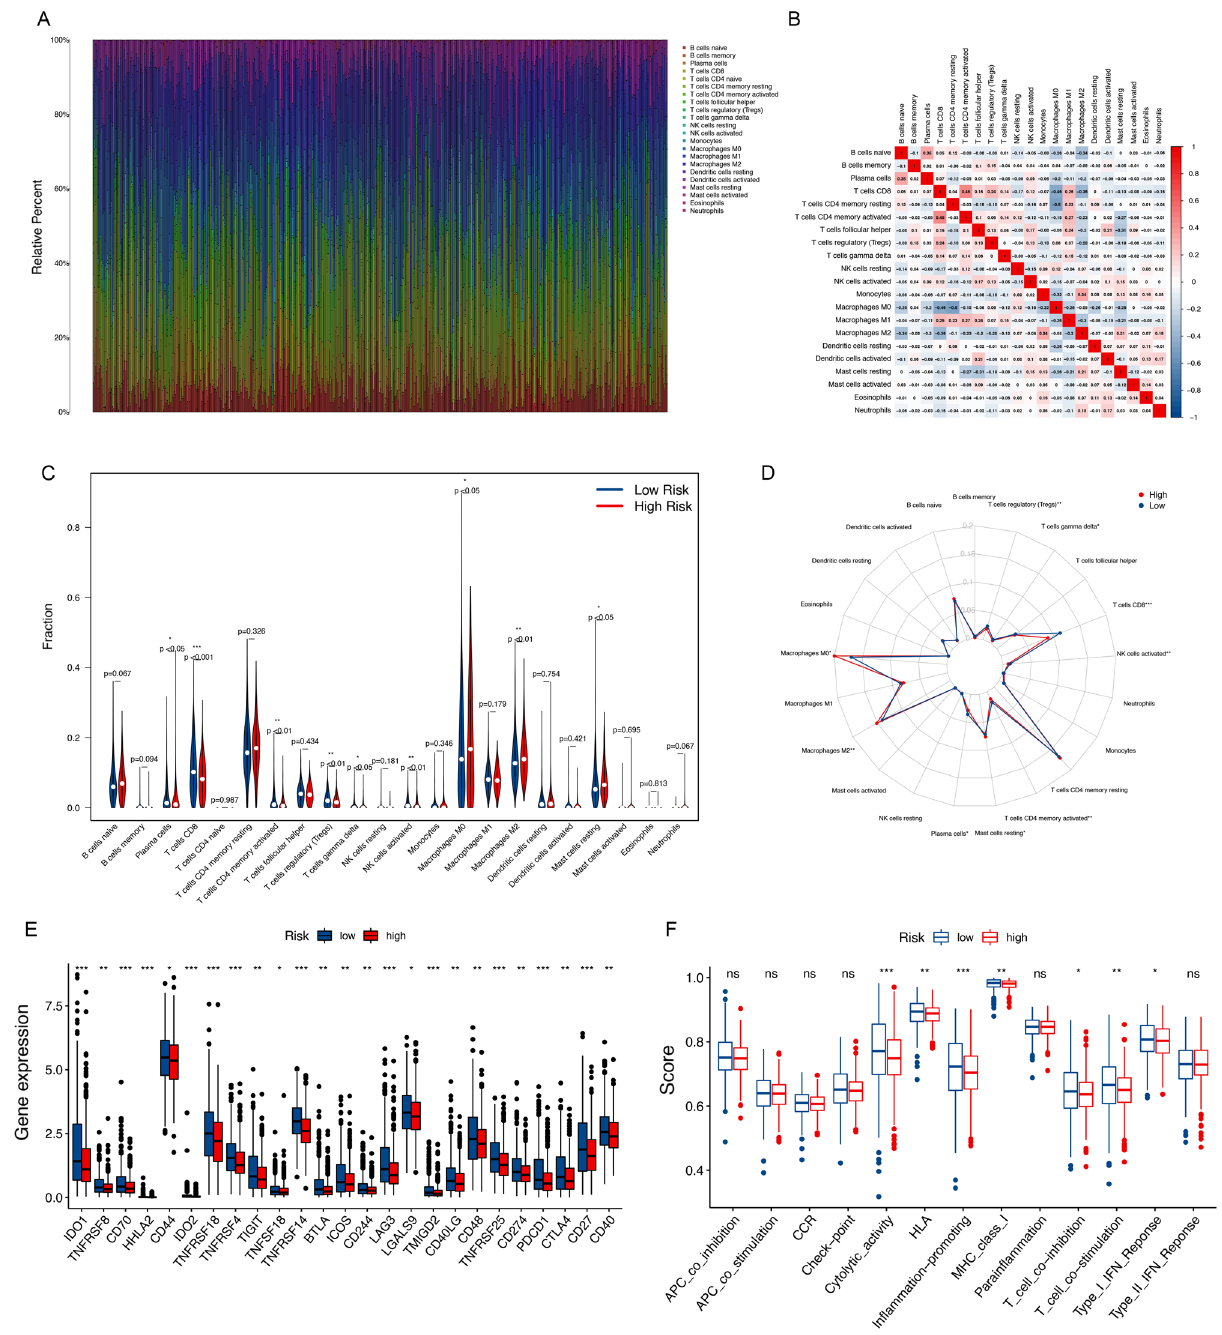
Figure 8. The immune cell infiltration landscape in BRCA. ( A ) Barplot of the proportions of the tumor- infiltrating cell. ( B ) Correlation matrix of the proportions of the tumor-infiltrating cell. ( C ) Violin plot showed the different proportions of tumor-infiltrating cells between the higher-risk and lower-risk groups. ( D ) Radar plot showed the different proportions of tumor-infiltrating cells between the higher-risk and lower-risk groups. ( E ) The expression levels of immune checkpoint molecules in the higher-risk and lower-risk groups. ( F ) The scores of immune functions in the higher-risk and lower-risk